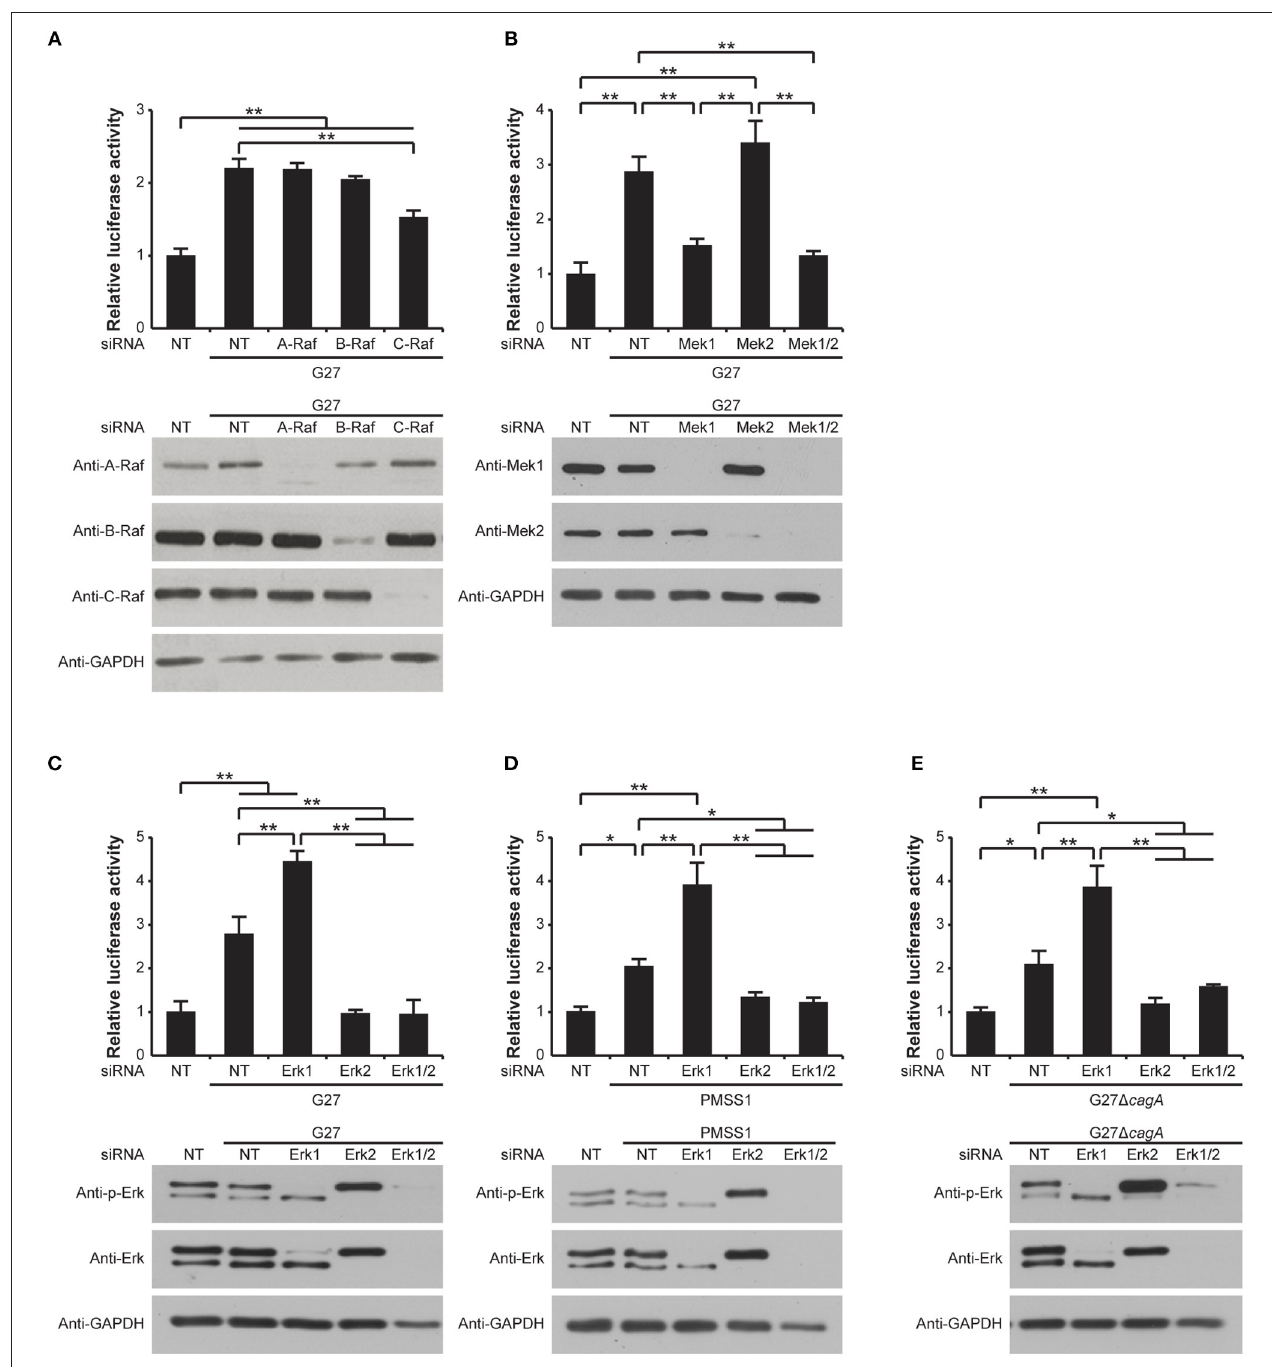
FIGURE 6 | Role of Raf, Mek, and Erk isoforms in the MAPK pathway in H. pylori -induced gastrin promoter activation. ( A–E , upper panels) G240-Luc cells were transfected with 100 pM of NT siRNA, (A) A-Raf, B-Raf, or C-Raf siRNA, (B) Mek1, Mek2, or both Mek1 and Mek2 (Mek1/2) siRNA, and (C–E) Erk1, Erk2, or both Erk1 and Erk2 (Erk1/2) siRNA. Forty-eight hours post transfection, cells were infected with (A–C) H. pylori strain G27, (D) PMSS1, or (E) G27 1 cagA for 5h. Luciferase activity is presented as a relative ratio to that of NT siRNA-transfected cells. The mean values ± SD of three separate experiments performed in triplicate are shown. * P < 0.05, ** P < 0.001. ( A–E , lower panels) Knockdown of (A) A-Raf, B-Raf or C-Raf, (B) Mek1 or Mek2, and (C–E) Erk1 or Erk2 were confirmed by Western blot. GAPDH was used as a loading control.